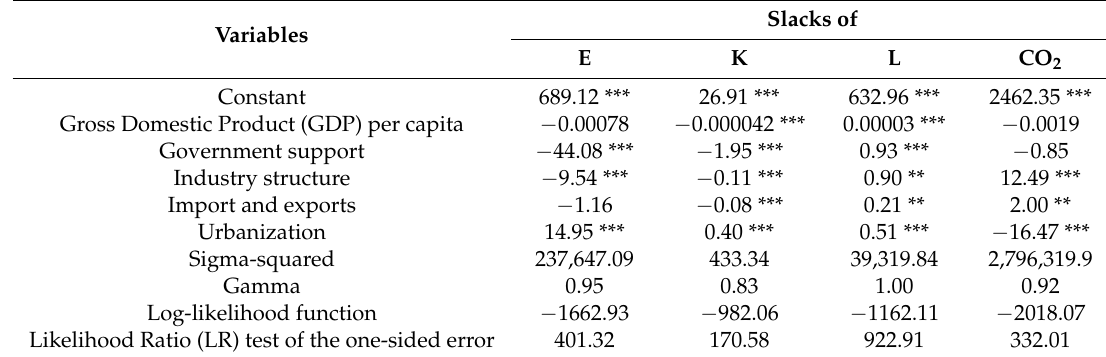
Table 4. The results of Stochastic Frontier Analysis